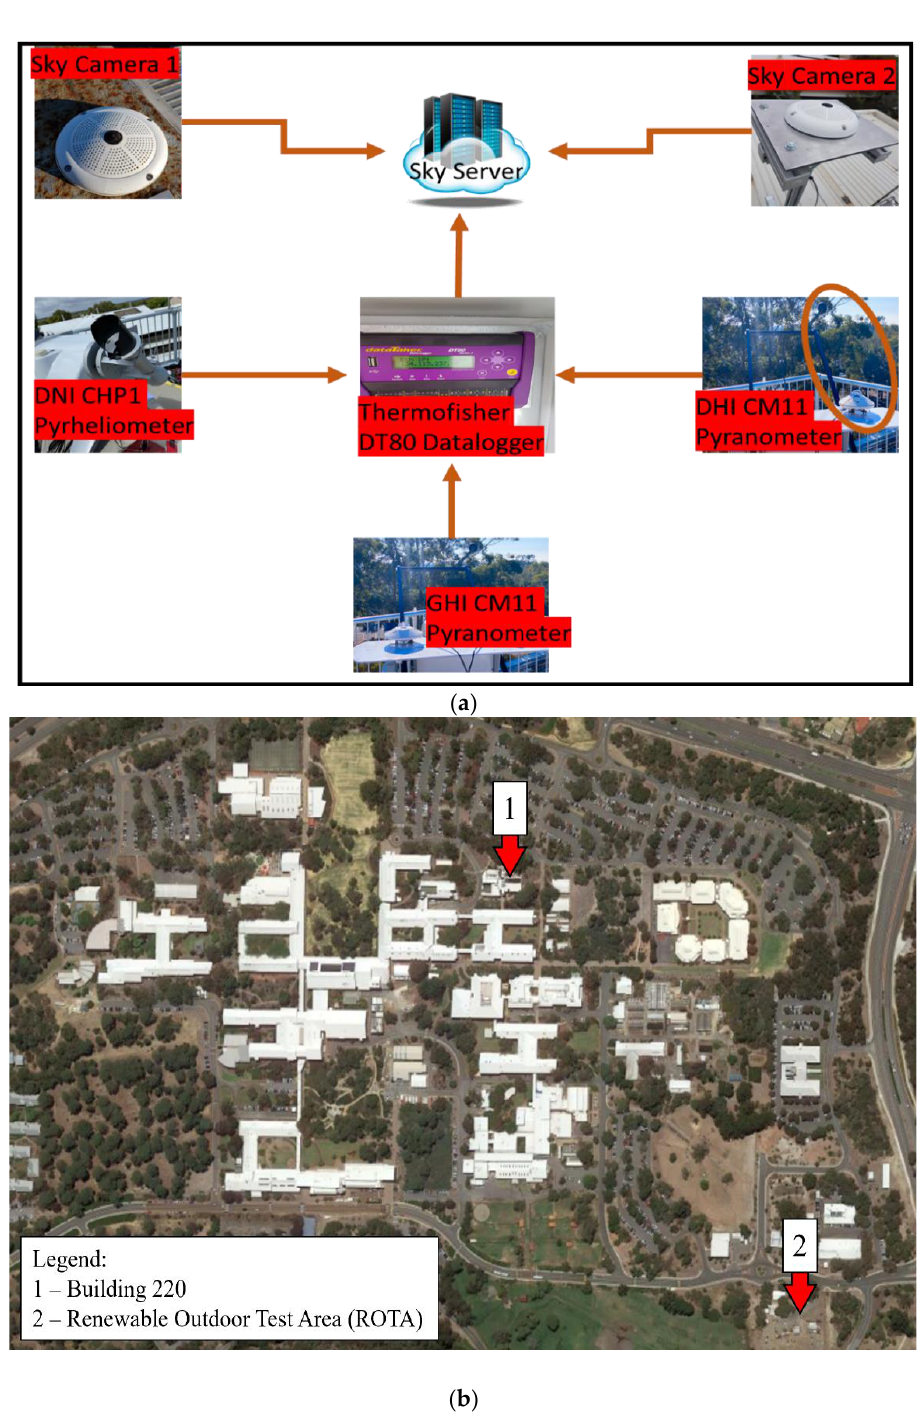
Figure 3. ( a ) Murdoch University ASI system overview. ( b ) Location of Building 220 and ROTA facility at Murdoch University.